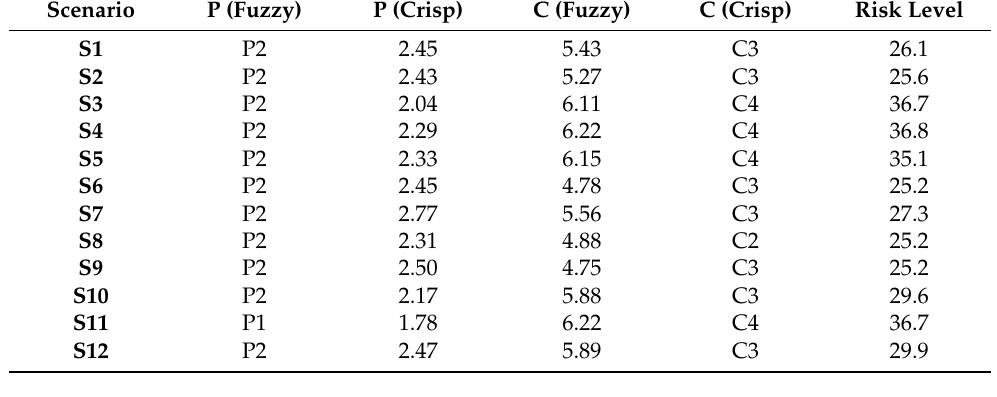
Table 9. The obtained results of the risk assessment for all analyzed scenarios.